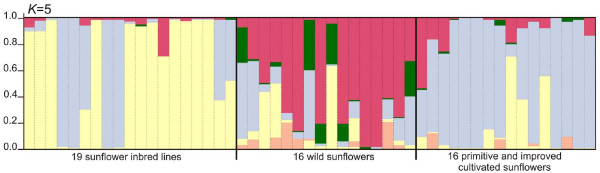
Population structure in sunflower inbred lines. Dash lines separate each individual, which is partitioned in K coloured segments that represent the individual's estimated membership fractions in K clusters. Black lines separate individuals from different groups. First group is composed by the 19 sunflower inbred lines (in order from left to right: HA52, HA61, HA89, HA292, HA303, HA369, HA370, HA821, HAR2, HAR3, HAR5, KLM280, PAC2, RHA266, RHA274, RHA293, RHA374, RHA801 and V94); the second and the third group are the individuals studied by Liu and Burke [46]. The inbred-lines group has mostly contributions of two clusters (yellow and light-blue).